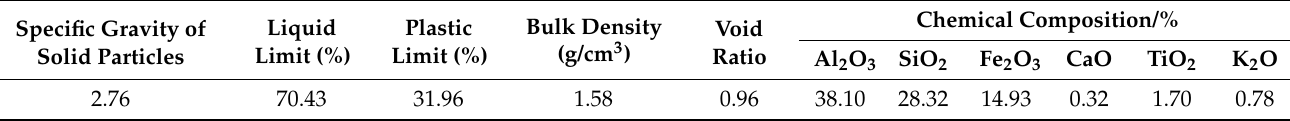
Table 2. Performance indices of SF and AF.